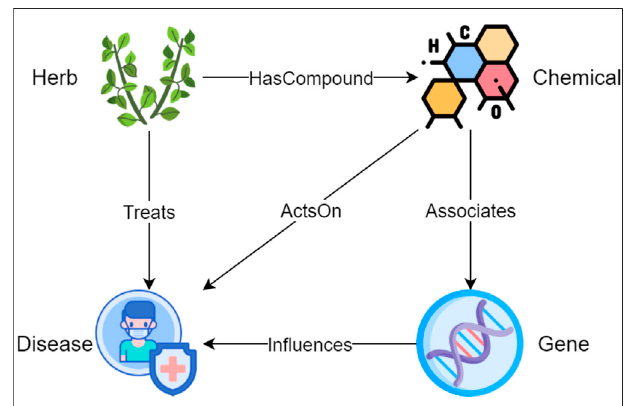
FIGURE 1 | The proposed Herb ontology consists of four entity types and fi ve relations. The four entity types are Herb, Chemical, Disease, and Gene; the fi ve relation types are HerbHasCompoundChemical (HHC), HerbTreatsDisease (HTD), ChemicalActsOnDisease